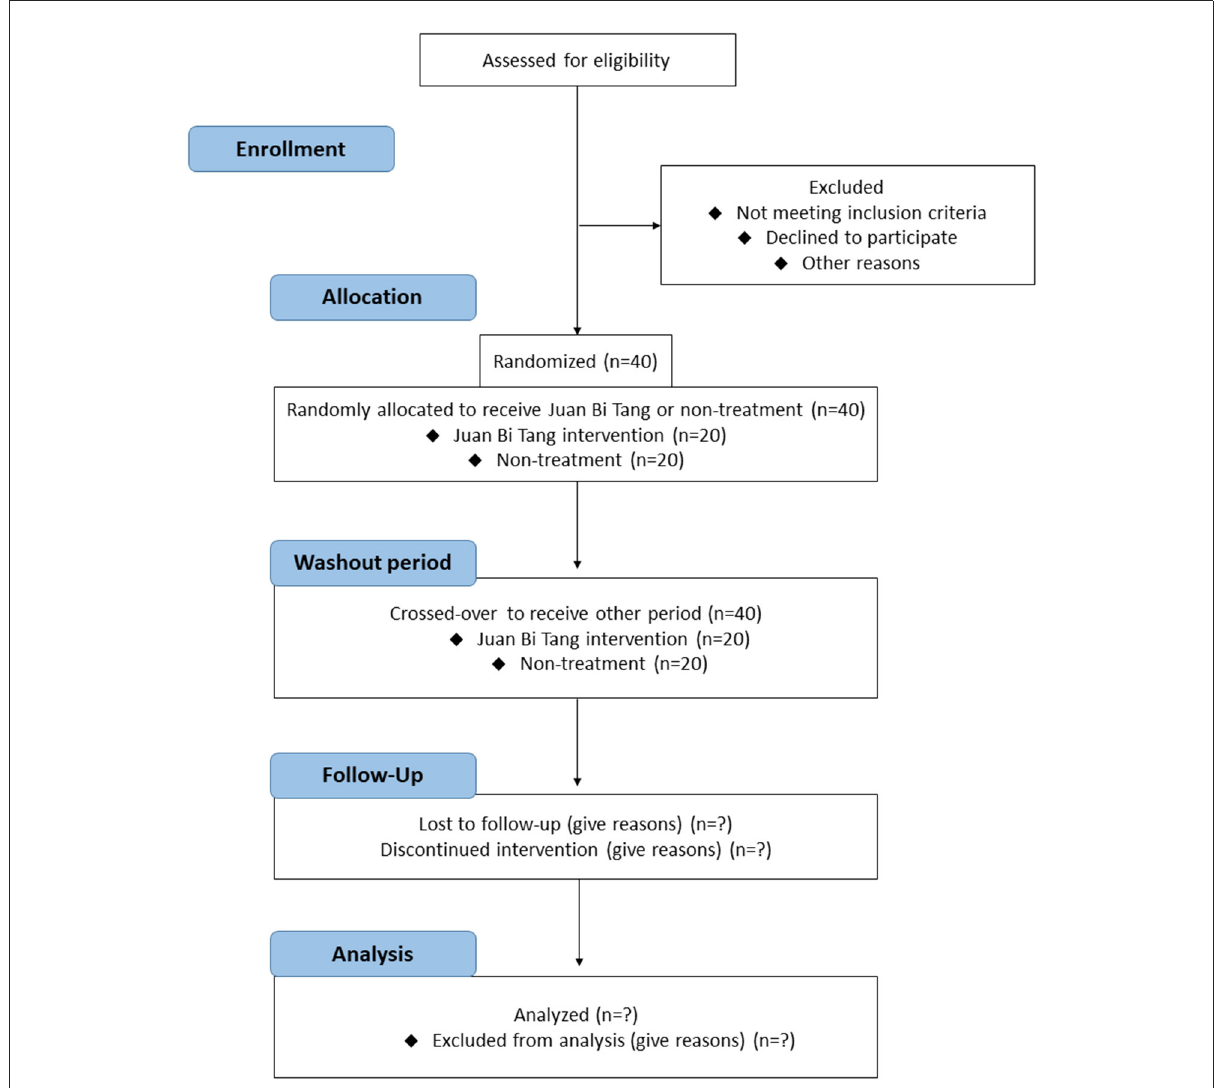
FIGURE1 Study design from enrollment to analysis following the CONSORT 2010 flow